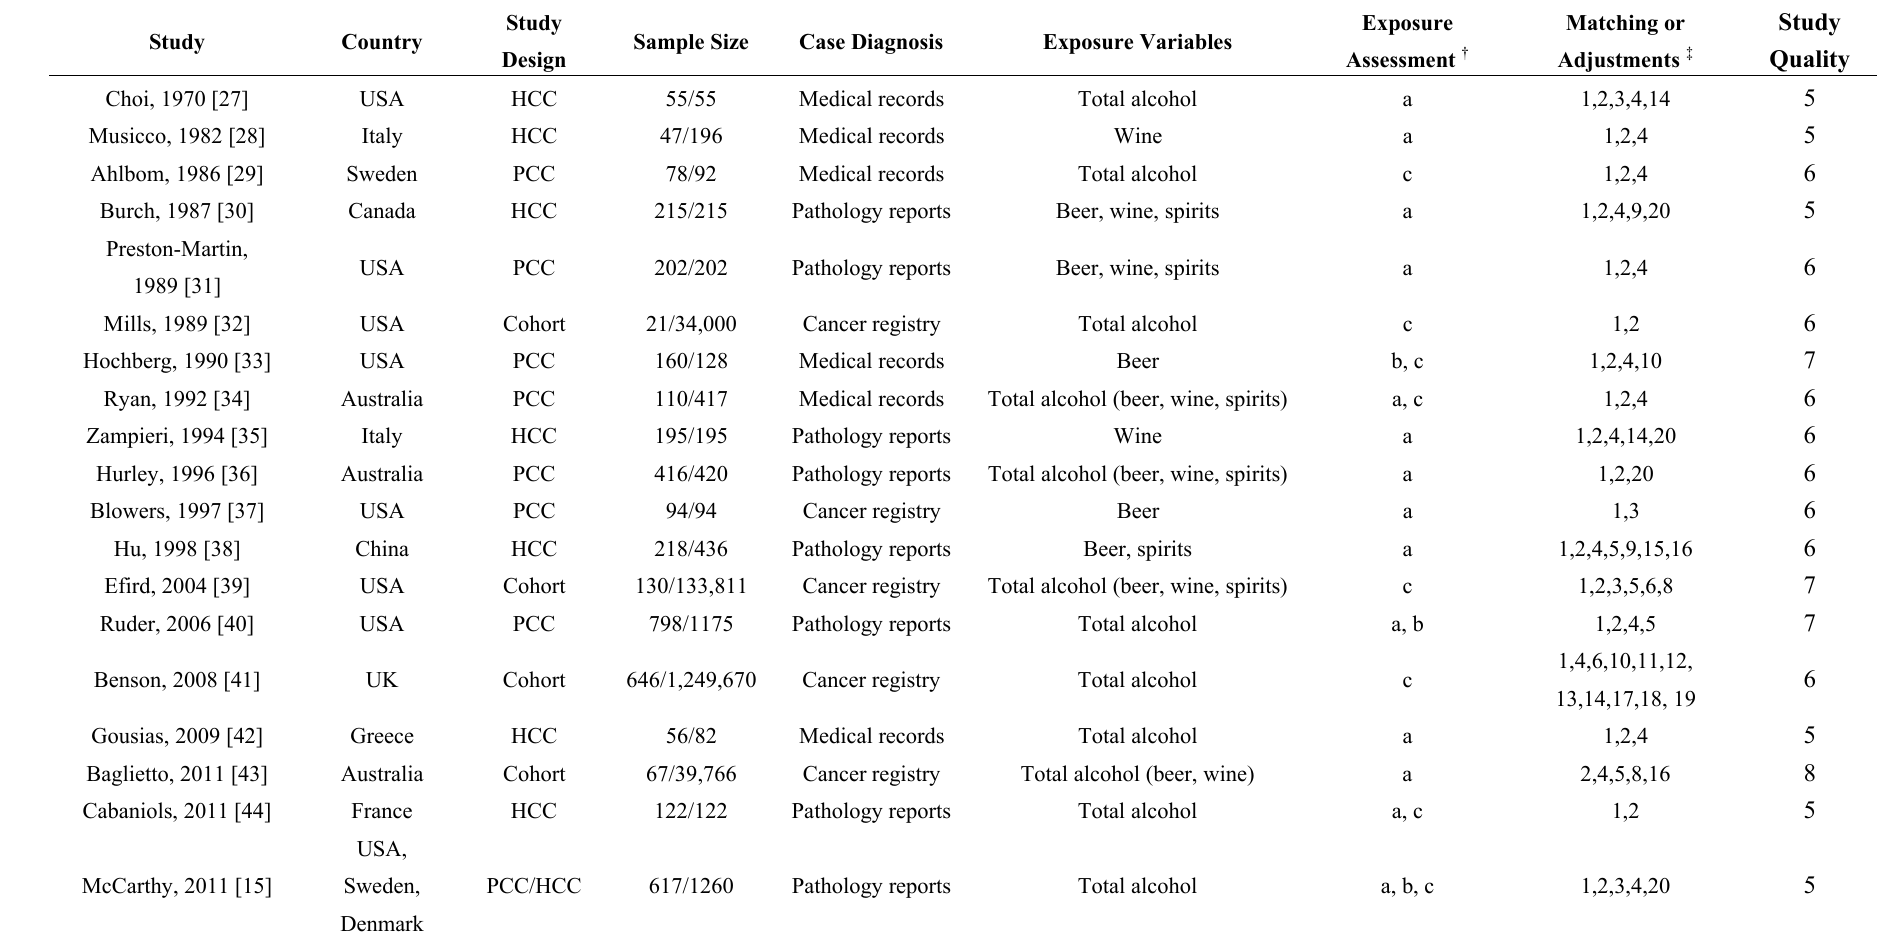
Table 1. Characteristics of studies included in the